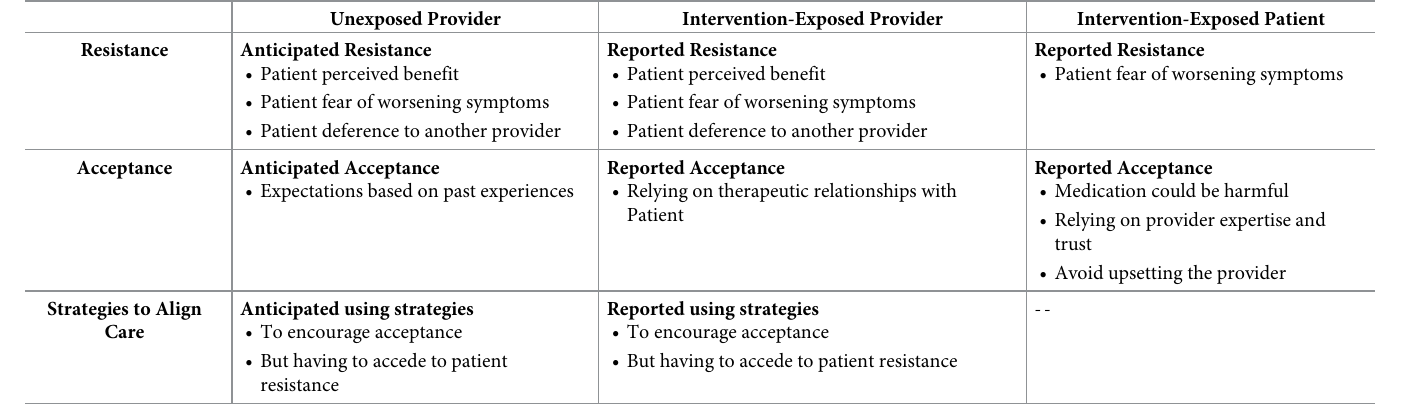
Table 2. Sub-themes of patient reaction.